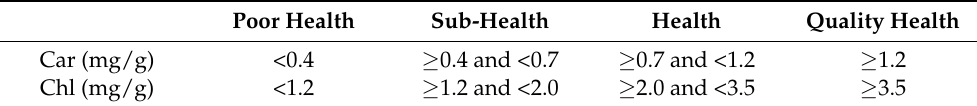
Table 2. Relationship between canopy health degree and canopy PPC in Populus euphratica individual